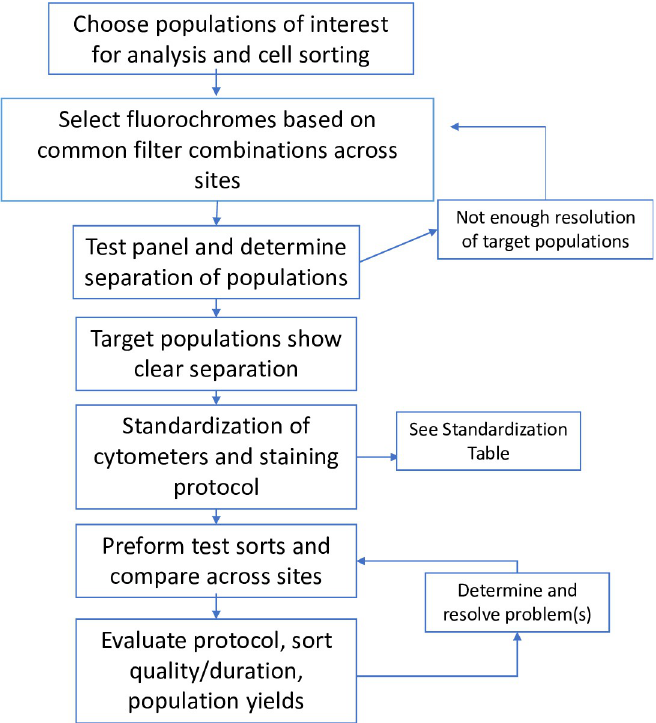
Fig 1. Overall schematic for flow cytometry optimization and standardization across clinical study sites. Schematic outlining the strategy used to improve the resolution of targeted populations of interest via flow cytometry.